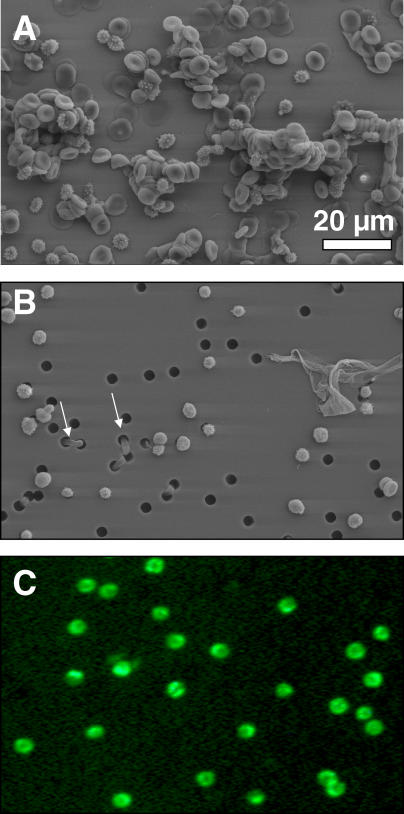
The Membrane Flow Cell Selectively Captures Lymphocytes and Provides for the Removal of Red Blood Cells without Sample Processing(A) A whole blood sample collected atop a glass slide and imaged by a scanning electron microscope reveals the overabundance of red blood cells in the sample.(B) A whole blood sample processed through the flow cell reveals that lymphocytes are captured on the membrane support while red blood cells are largely excluded from within the cell. Arrows indicate red blood cells passing through the membrane.(C) Fluorescent antibody stain specific for a lymphocyte marker is used to visualize captured lymphocytes within the flow cell in a representative single-color data image.